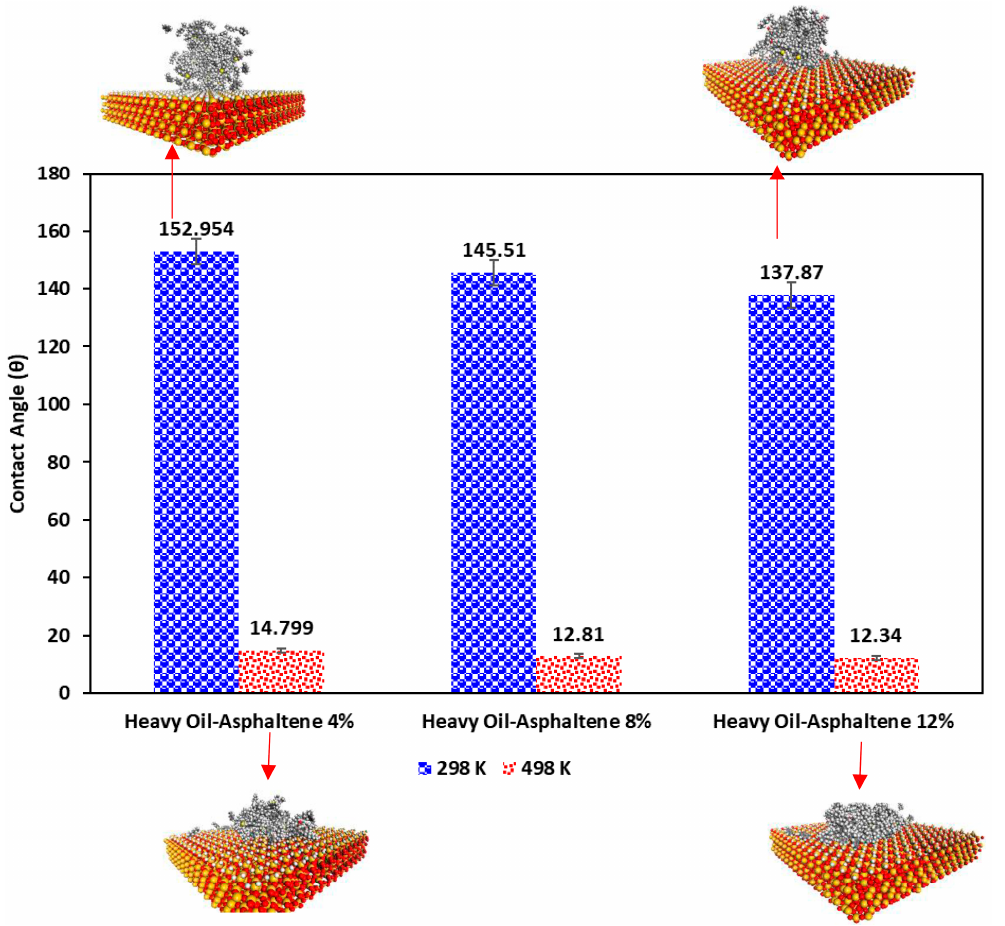
Figure 1. Comparison between the contact angles in each system and different temperatures (for the clarity purposes, water molecules in snapshots are hidden).